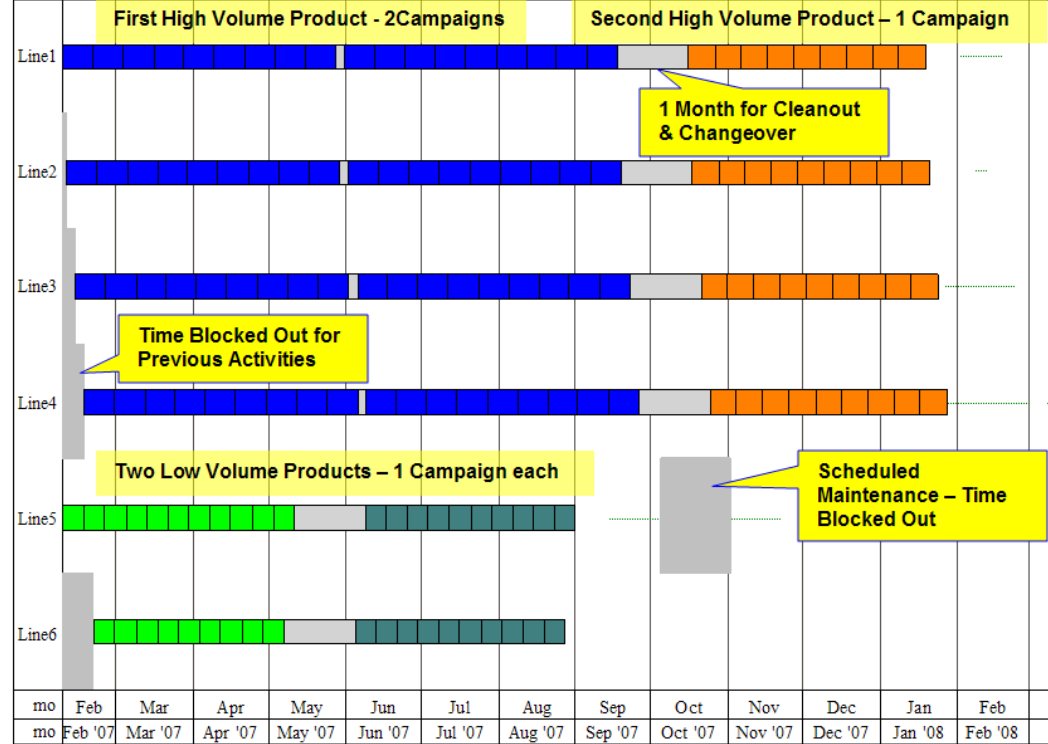
Figure 7. Line occupancy chart for capacity analysis and strategic